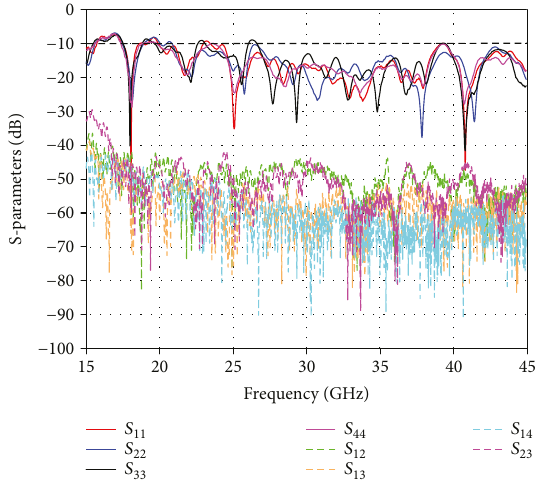
Figure 15: Measured re fl ection coe ffi cient S unit cell when connected to the modi fi ed